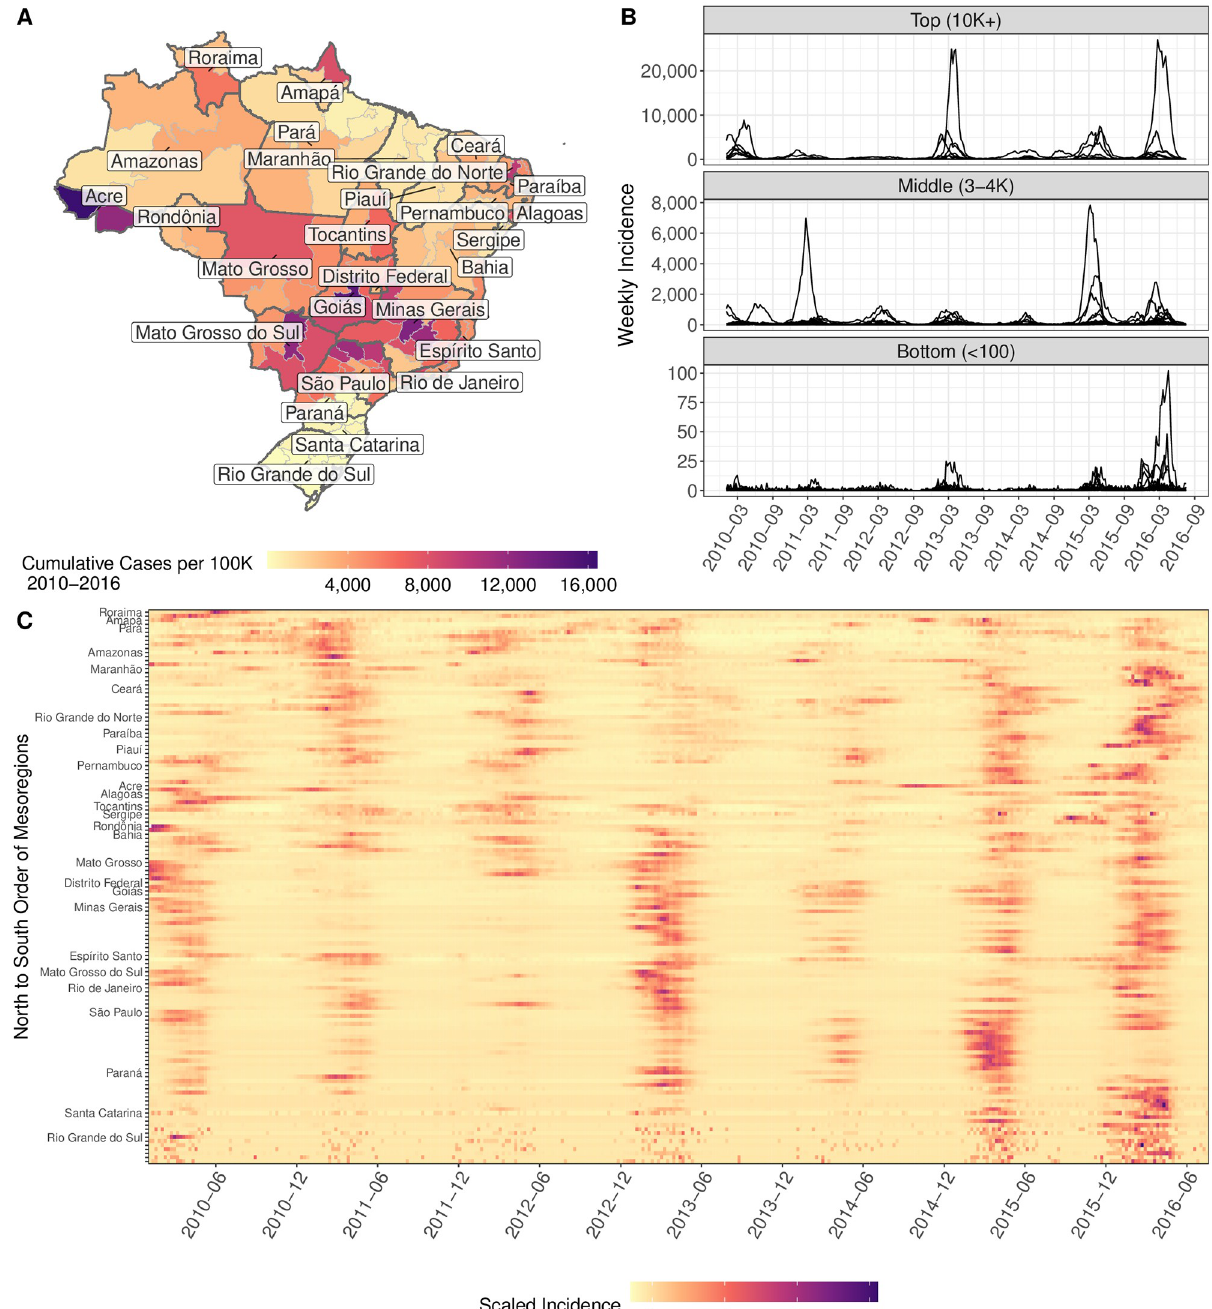
Fig 1. The spatio-temporal heterogeneity of weekly DENV case data across 137 mesoregions from 2010–2016. (A) Cumulative incidence over the six-year study period. States are outlined in darker grey and labeled. The underlying shapefiles with political boundaries are publicly and freely available at Instituto Brasileiro de Geografia e Estatı´stica (IBGE) http://downloads.ibge.gov.br/downloads_geociencias.htm. (B) Examples of mesoregion weekly DENV time series. Mesoregions were sorted according to cumulative incidence over the six-year study period as follows: “Top” mesoregions recorded greater than 10K cases per 100K individuals, “Middle” recorded 3–4K cases per 100K individuals, and “Bottom” recorded fewer than 100 cases per 100K individuals. Top mesoregions come from Acre, Minas Gerais, Rio de Janeiro, S ã o Paulo, Mato Grosso do Sul, and Goia´s; Middle come from Rondoˆnia, Amazonas, Ceara´, Rio Grande do Norte, Pernambuco, Alagoas, Minas Gerais, S ã o Paulo, and Mato Grosso; Bottom come from Parana´, Santa Catarina, and Rio Grande do Sul. (C) Weekly DENV incidence in each mesoregion. Each time series was transformed to zero mean and unit variance. Mesoregions are ordered from north (top) to south (bottom) by the listed state and then by mesoregion within state.